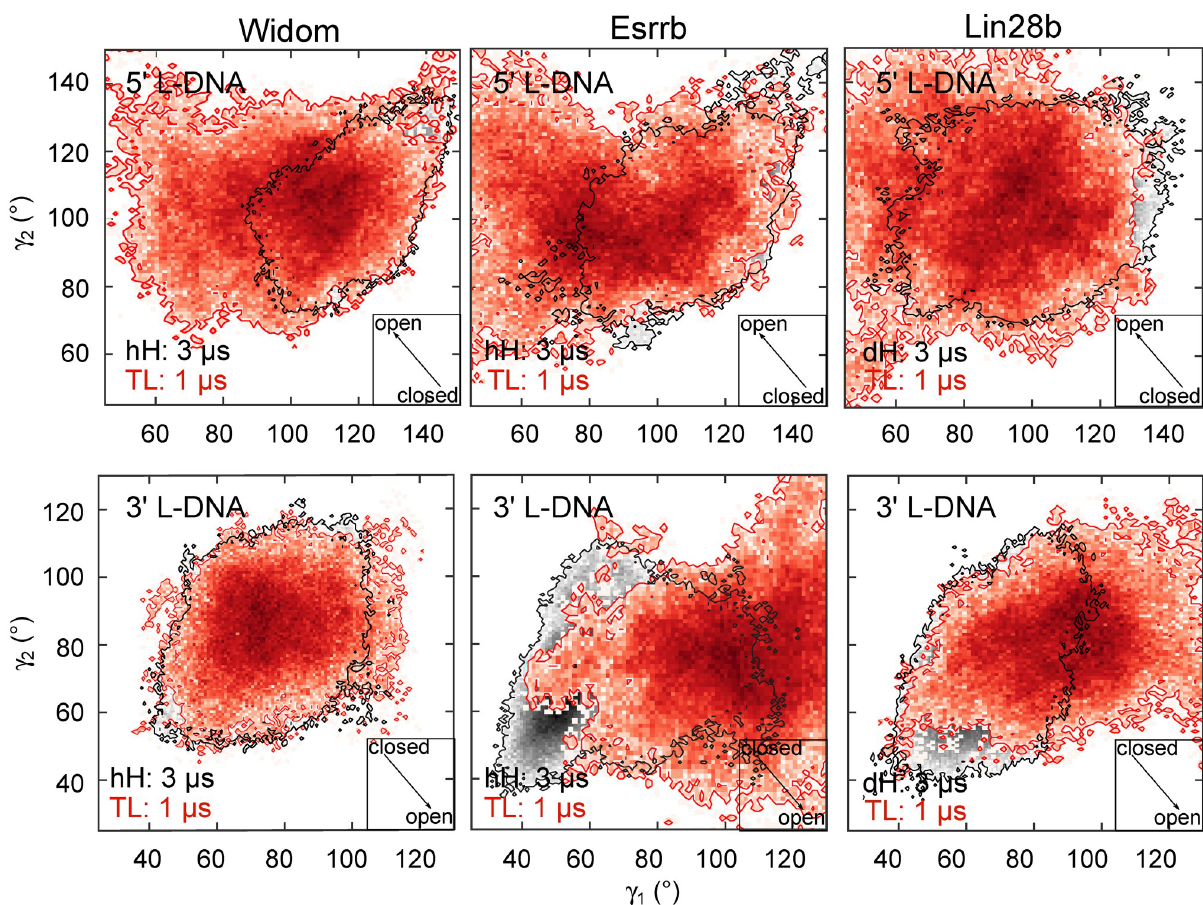
Fig 3. Enhanced breathing of tail-less nucleosomes. Two-dimensional histograms depicting the conformational sampling of the 5’ and 3’ L-DNA arms in the space defined by the γ 1 and γ 2 angles. The arrow inserts in the lower-right corner indicate the direction of the opening, whereas the numbers are the areas of the histograms. The crosses indicate the most populated region of each histogram. The data for the 1 μ s tail-less simulations is depicted in red, whereas the sampling of the complete nucleosome is showed in black.